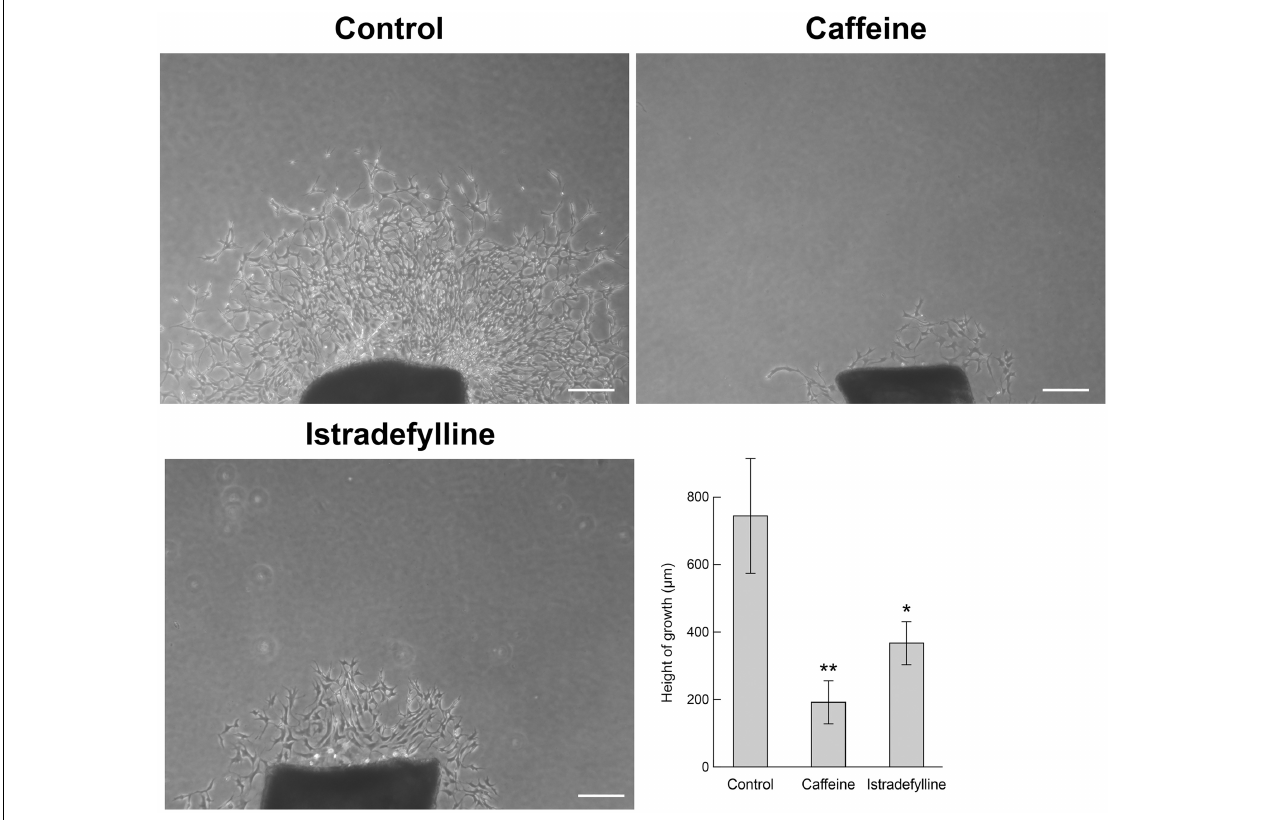
FIGURE 5 | Caffeine and istradefylline mitigate thoracic aortic ring sprouting. Aortic rings were prepared from 3-week-old C57BL/6j mice, embedded in Matrigel in the presence of caffeine (200 µ M), istradefylline (selective A 2 A receptor antagonist; 10 µ M) or vehicle. Seven days later, aortic rings were photographed, and the mean area of outgrowths was quantified. Scale bar = 200 µ m ( ∗ p < 0.05; ∗∗ p <